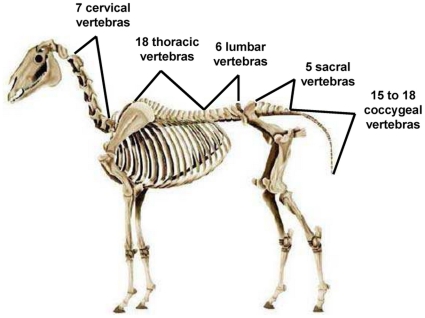
The five vertebral areas (cervical, thoracic lumbar, sacral and coccygeal) of the horse's skeleton.Adapted from Aublet [57].